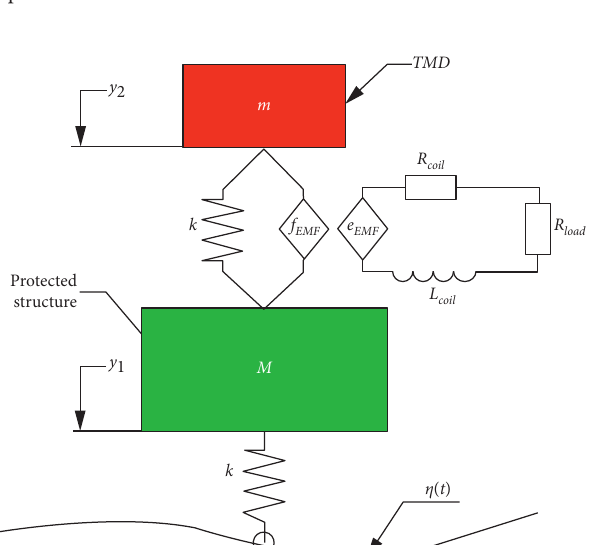
Mathematical model of the typical TMD